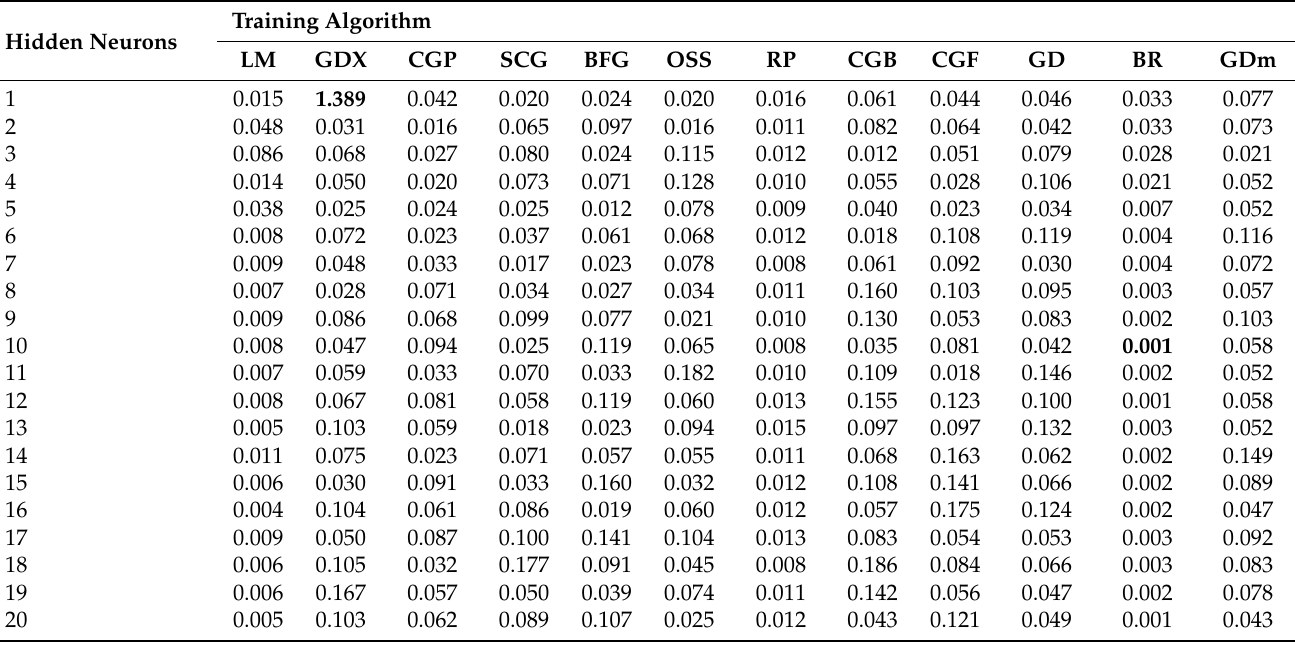
Table A16. MAE for methane yield for different training algorithms at different number of hidden